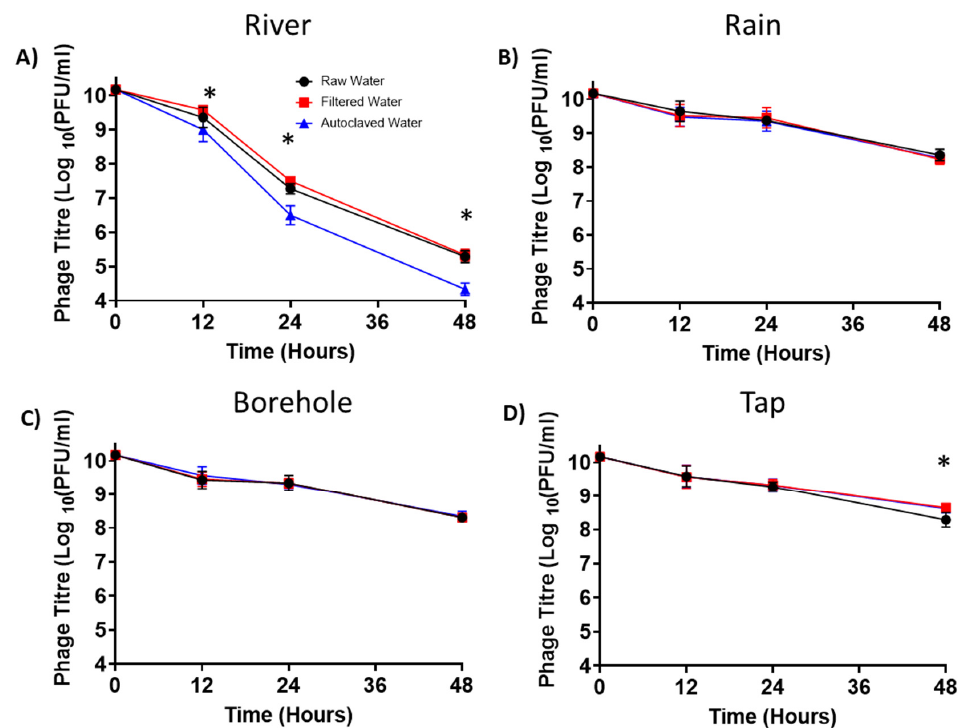
Figure 8. Phage persistence in water from different sources. Phage persistence in ( A ) river water and ( B ) rainwater. * Significant difference between filtered and autoclaved water, from 12 to 40 h of incubation ( p values ranging from <0.0001 to 0.0396). Phage persistence in ( C ) borehole water and ( D ) tap water. * Significant differences between raw and filtered water at 48 h of incubation ( p = 0.0365). Black circle: raw water, red square: filtered water, blue triangle: autoclaved water. All experiments were repeated twice and measured in triplicate. Error bars represent the standard error of the mean (±SE).